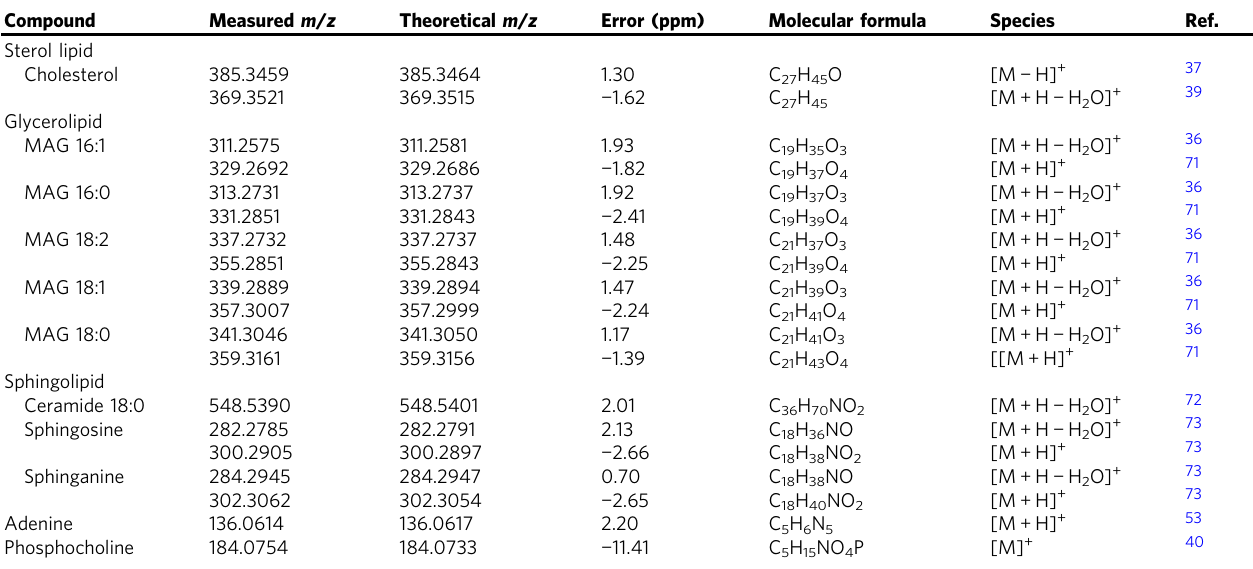
Table 1 Assigned lipids, metabolites, and derivatives from mouse hippocampal tissue slices in the positive ion mode using